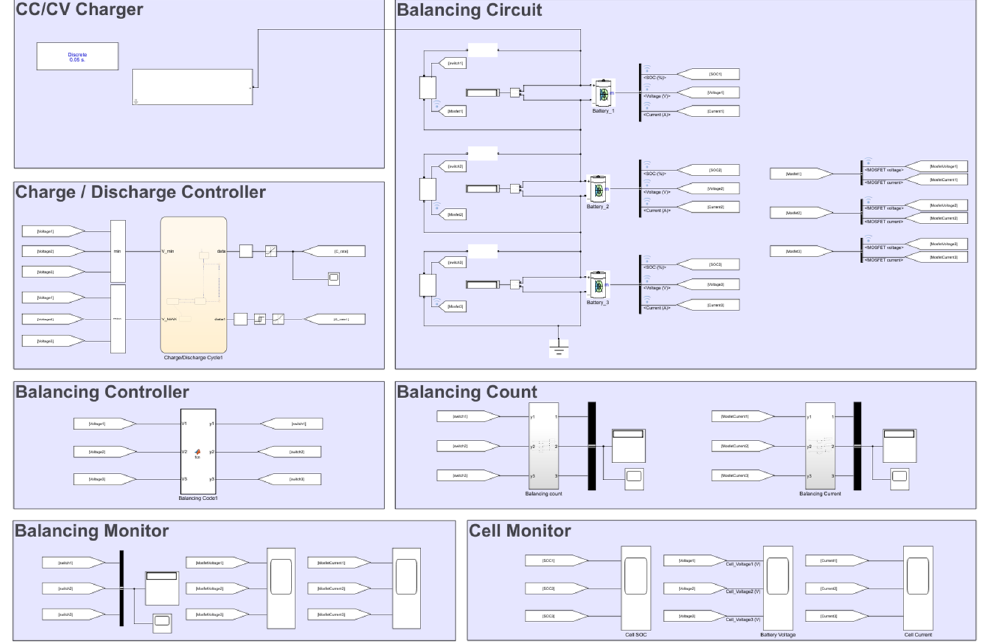
Figure 1. A model with a battery module and a battery management system.